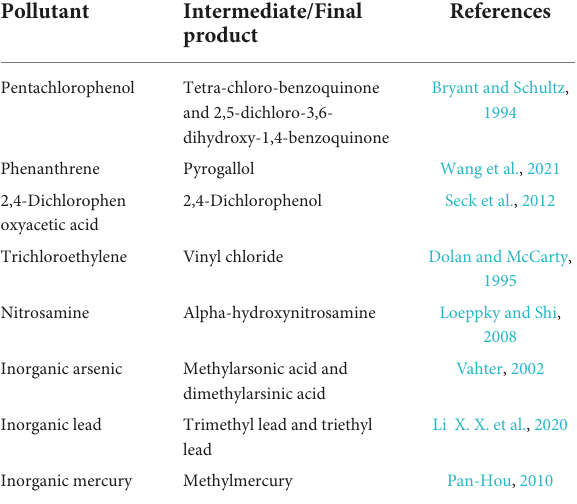
TABLE 1 A list of microbial toxicity of parent pollutants weaker than